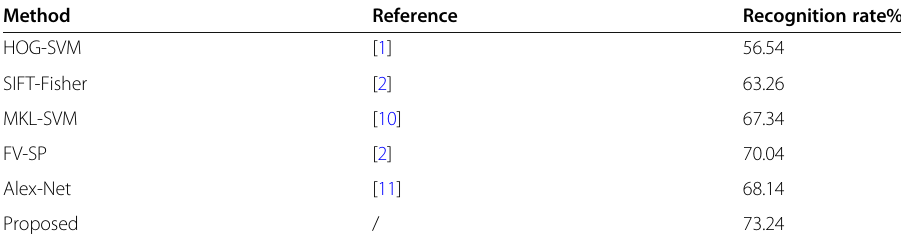
Table 2 The comparison of recognition rate Method